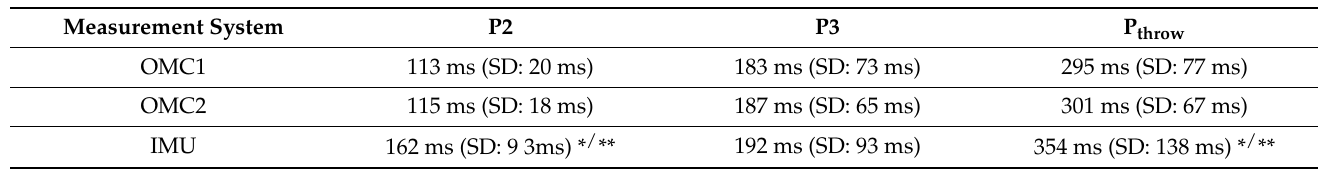
Table 2. Mean values of the different throw phases depicted as P2 and P3 and the total throw time (P throw ) and standard deviations (SD) for all three measurement systems.